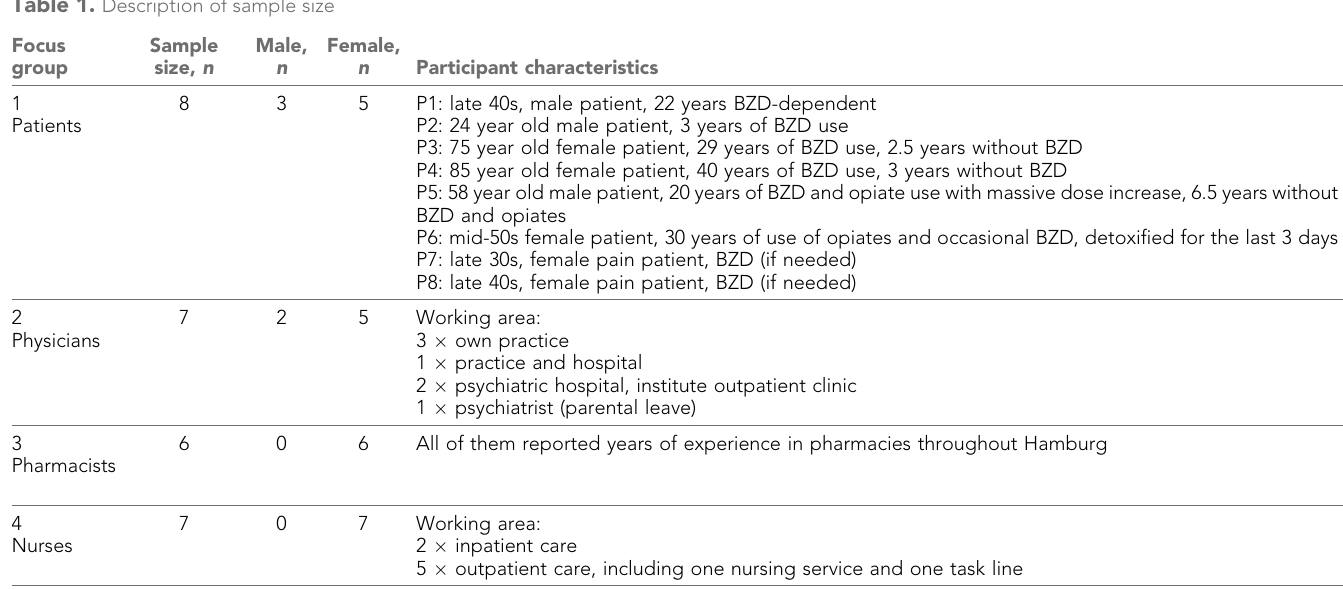
Table 1. Description of sample size Focus